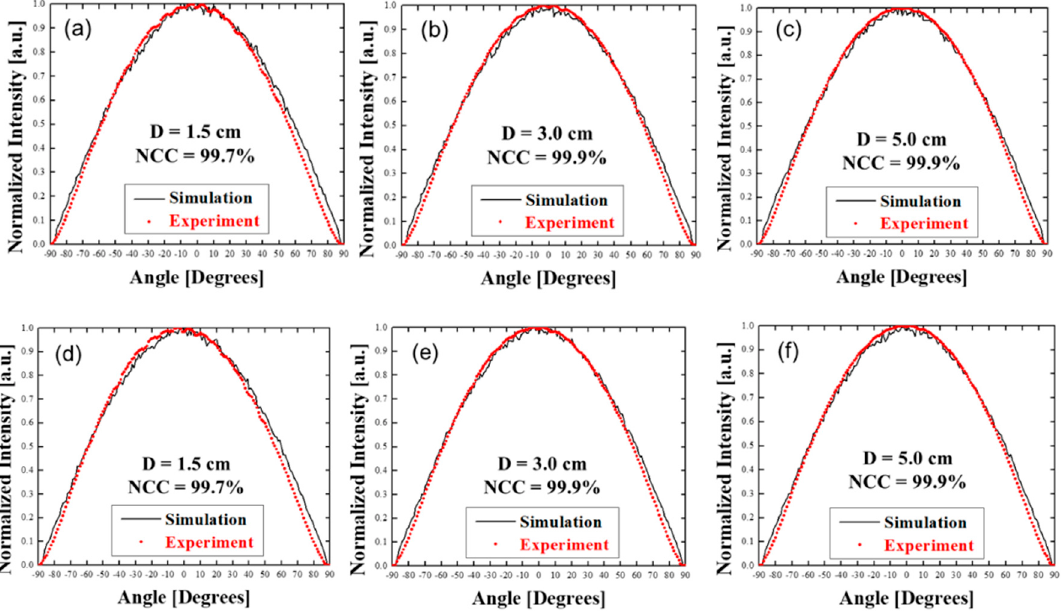
Figure 3. Comparison of the simulated and measured normalized cross-correlation values in the midfield regime and beyond along the horizontal direction at the distance of ( a ) 1.5, ( b ) 3, and ( c ) 5 cm and along the vertical direction at the distance of ( d ) 1.5, ( e ) 3, and ( f ) 5 cm.